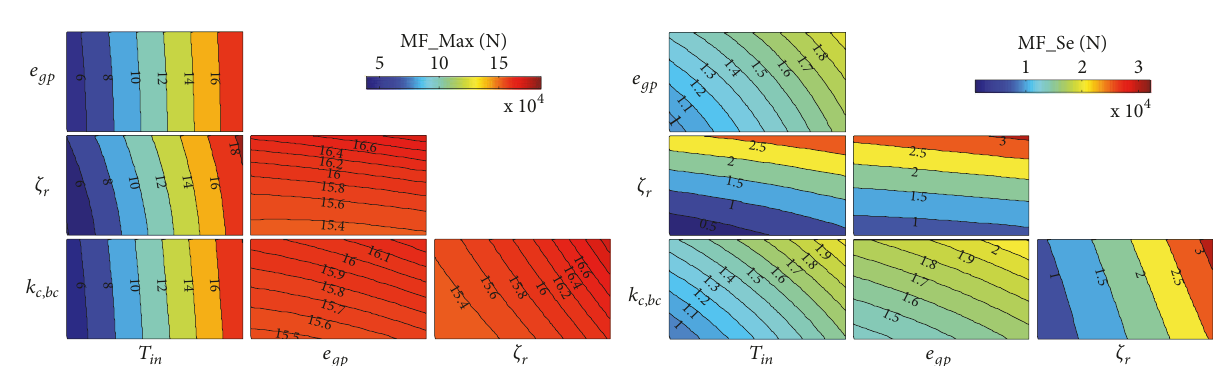
Figure 15: Variation of dynamic meshing force (MF) with respect to the parameters with the greater